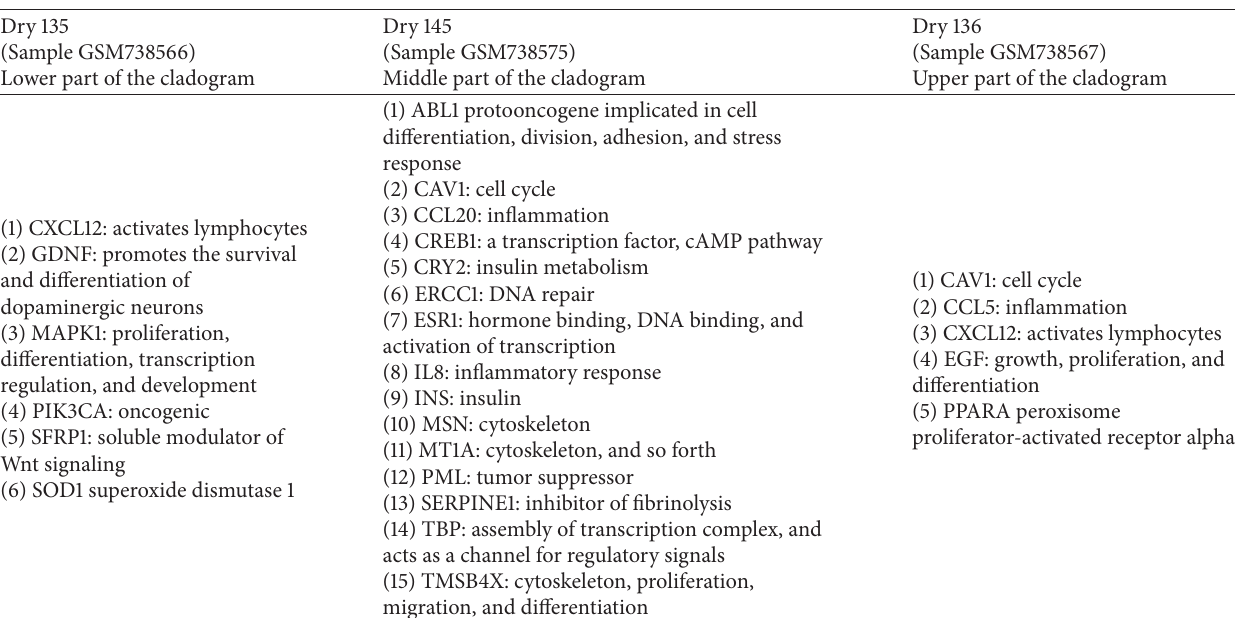
Table 4: Affected RPE-choroidal signaling pathways at different locations of cladogram in Figure 2. Sample identification follows http://www.ncbi.nlm.nih.gov/geo/query/acc.cgi?acc=GSE29801. Updates on genes’ functions can be obtained from http://www.ncbi.nlm